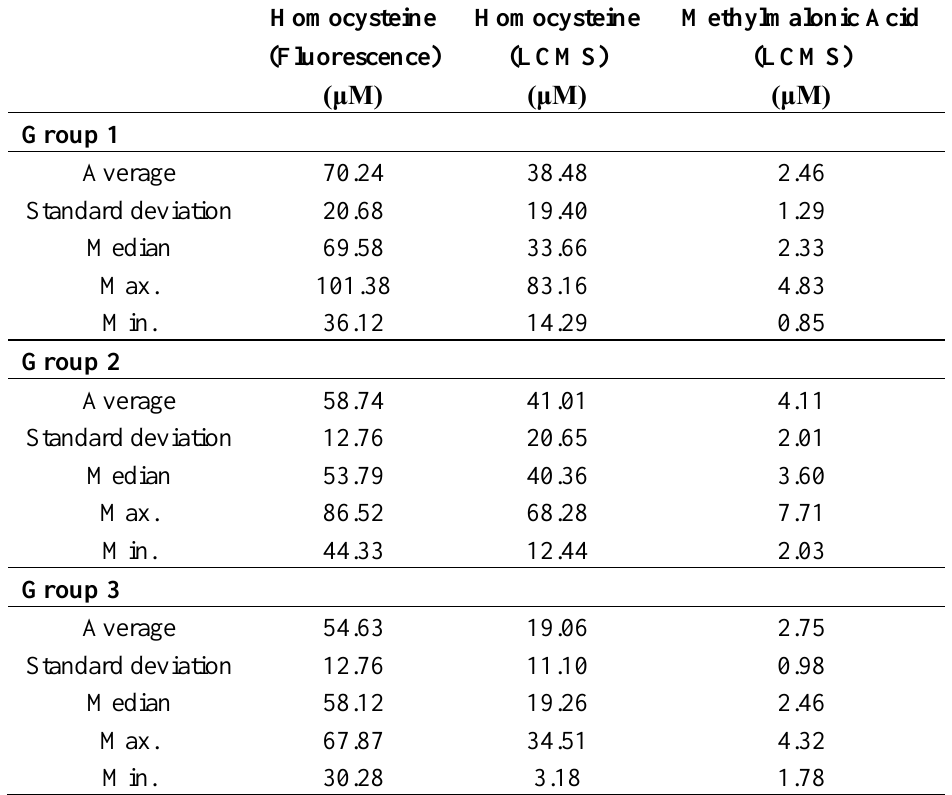
Table 1. Comparison of data from fluorescence and LC-MS detection of homocysteine and methylmalonic acid in PD patient